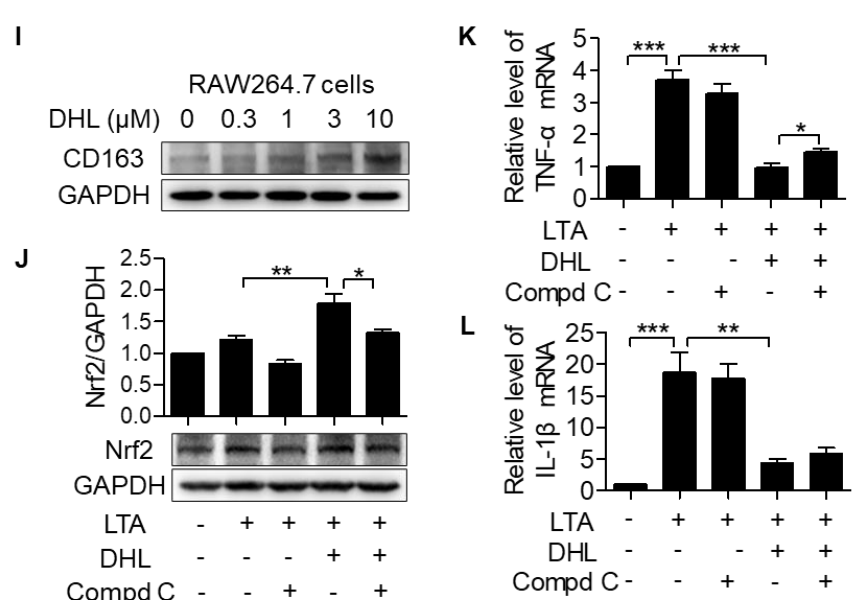
Figure 3. DHL restrains M1 phenotype macrophage activation while accelerating M2 macrophage polarization in RAW 264.7 cells and primary BMDMs. RAW264.7 cells ( A – C ) and BMDMs ( D – F ) were preincubated with different concentrations of DHL for 0.5 h, followed by stimulation with LTA (20 μg/mL) for 4 h. Cells were collected and total RNAs were isolated, then mRNA levels of M1-like inflammatory cytokines ( TNF-α , IL-1β, and IL-6 ) were measured by real-time PCR. ( G – I ) Protein contents of M1 (iNOS) and M2 (CD163) marker genes. RAW264.7 cells ( G ) and BMDMs ( H ) were pretreated with the indicated concentration for 0.5 h, then stimulated with LTA (20 μg/mL) for another 24 h. ( I ) RAW264.7 cells were pretreated with the indicated concentration of DHL for 24 h. Cell lysates were prepared for Western blot analysis, GAPDH was used as loading control. ( J – L ) RAW264.7 cells were pretreated with Compound C (Compd C) for 0.5 h, followed by incubation with DHL for 0.5 h, then stimulation with LTA (20 μg/mL) for another 0.5 h (J) or 4 h (K-L). ( J ) Cell lysates were collected for immunoblotting to evaluate the expression of Nrf2, and the ratio of Nrf2/GAPDH was calculated by densitometry. ( K – L ) Cells were collected and total RNAs were isolated, then mRNA levels of M1-like inflammatory cytokines ( TNF-α and IL-1β ) were measured by real-time PCR. Data are represented as mean ± SEM, n = 3, * p < 0.05, ** p < 0.01, *** p < 0.001.